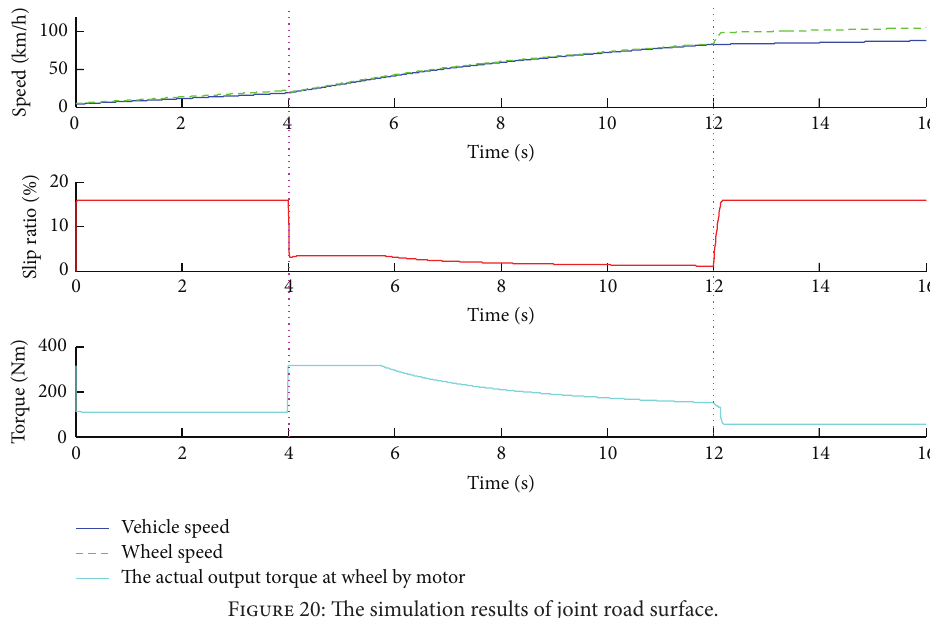
Figure 20: The simulation results of joint road